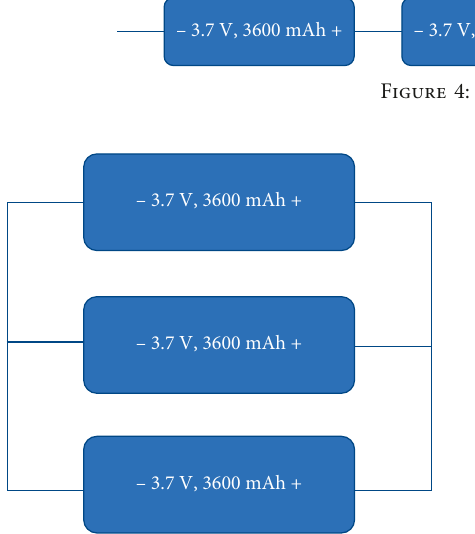
Figure 5: Parallel cell arrangement.